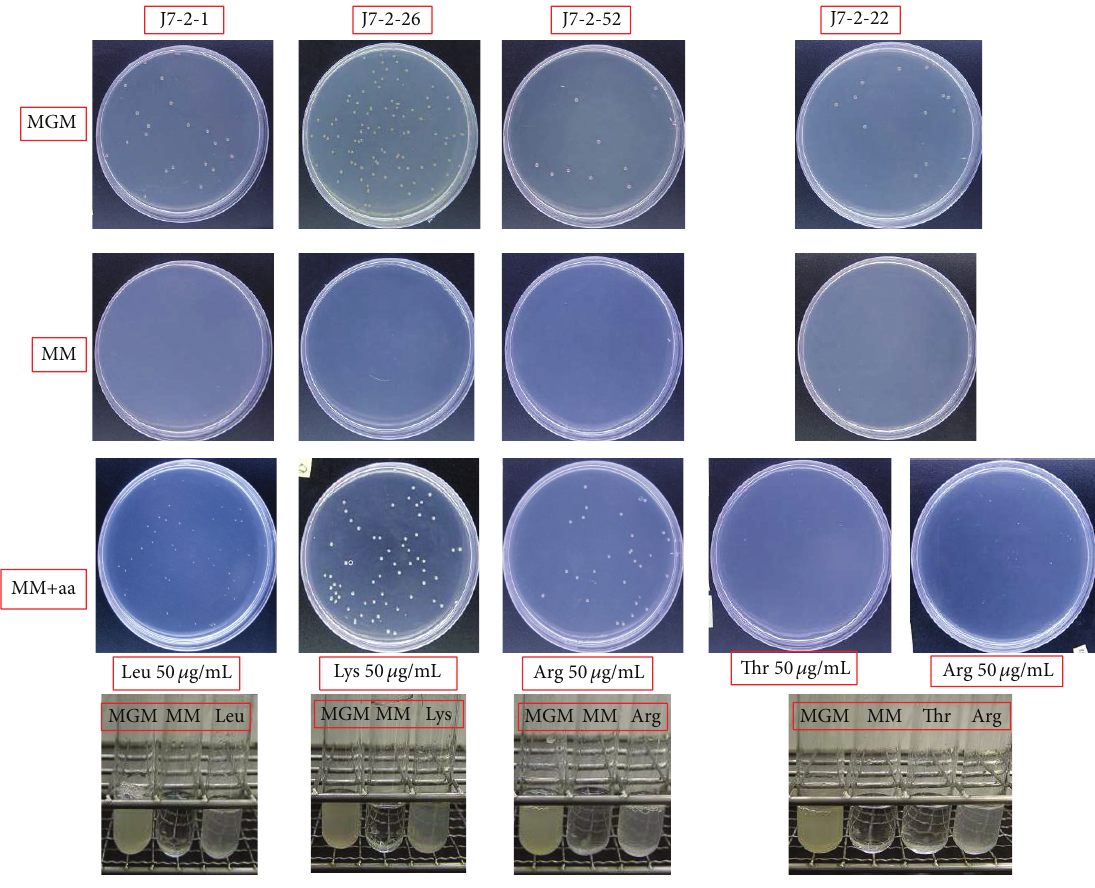
Figure 1: Growth behavior of the auxotrophic strains in different media. The method used to determine the nutrients required for the four auxotrophic mutants is described in Materials and Methods, after which the phenotypes of the mutants were confirmed. We picked out a single colony of each of the four mutants and cultivated it in a liquid MGM medium at 42 ∘ C. The cultures of each strain were obtained, centrifuged, and resuspended in MM medium. Then, the suspended cultures were inoculated in liquid media of MGM, MM, and MM with the corresponding nutrients added (as shown in the figure, leucine was added to the MM medium to reconfirm the phenotype of J7-2-1; lysine was added for reconfirming J7-2-26, arginine for J7-2-52, and threonine and arginine for J7-2-22). In corresponding solid media, the suspended cultures were diluted with MM media before spreading on the corresponding media plates. Their growth states were recorded and pictures were taken after storage at 42 ∘ C for 7–15 days. MGM: a complete medium that could support the growth of all J7-2 auxotrophic strains; MM: a minimal medium that could only support the growth of the J7-2 prototrophic strain; MM+aa: MM supplied with the relevant single amino acid to a final concentration of 50 𝜇